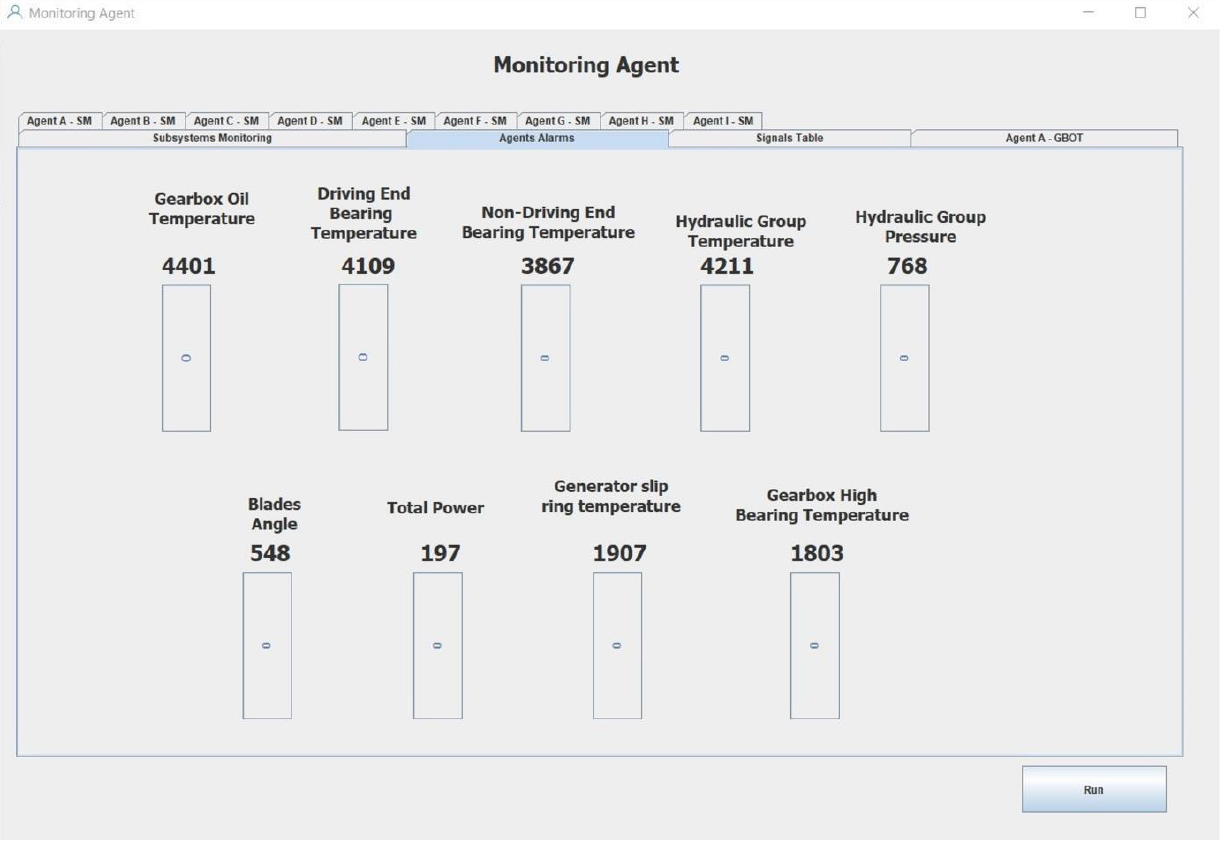
Figure 13. Count of alarms for each variable. A rapid increase in the alarm count within a short period may mean that there are damaged sensors, communication problems between the sensors and the data acquisition system, or failure in operating conditions of the monitored devices. Similarly, the occur- rence of high alarm rates in many of the subsystems that constitute the wind turbine is a significant sign that the wind turbine is at the end of its useful life